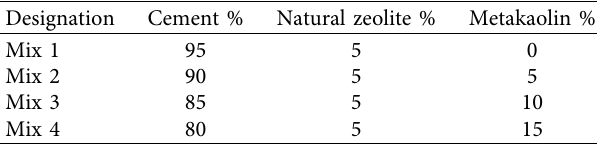
Table 2: Mix design of